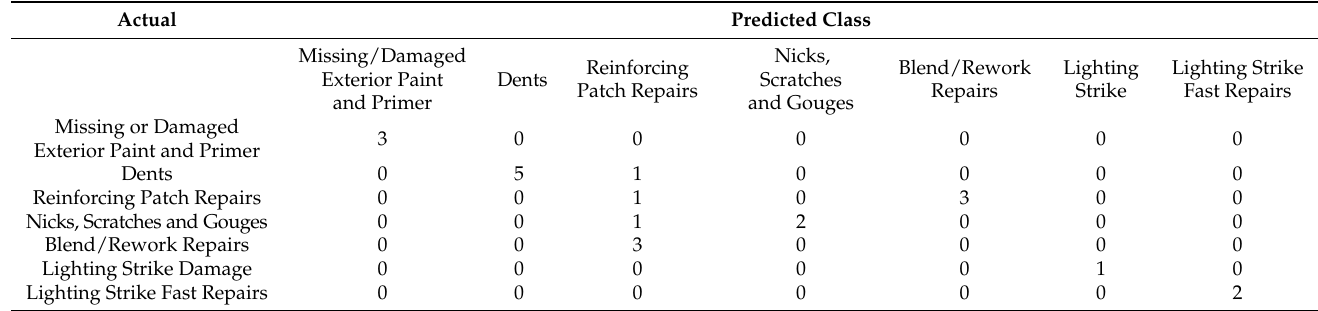
Table 16. Confusion matrix of